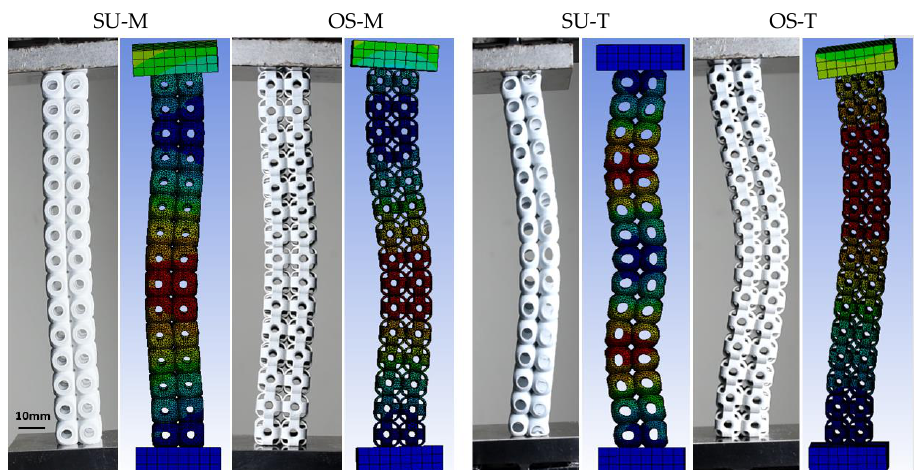
Figure 12. Numerical compression of the 2 × 2 × 15 structure with eigenvalue buckling analysis in ANSYS static structure. The numerically critical buckling load (Pcr) values are consistent with the experi- mental value, and no significant difference is recorded between them, as shown in Figures 13 and 14. Only the column OS-T structure recorded a difference with a percentage of Figure 7. 12%. This difference occurred because the powders were stuck in the sample, as shown in Figure 7.